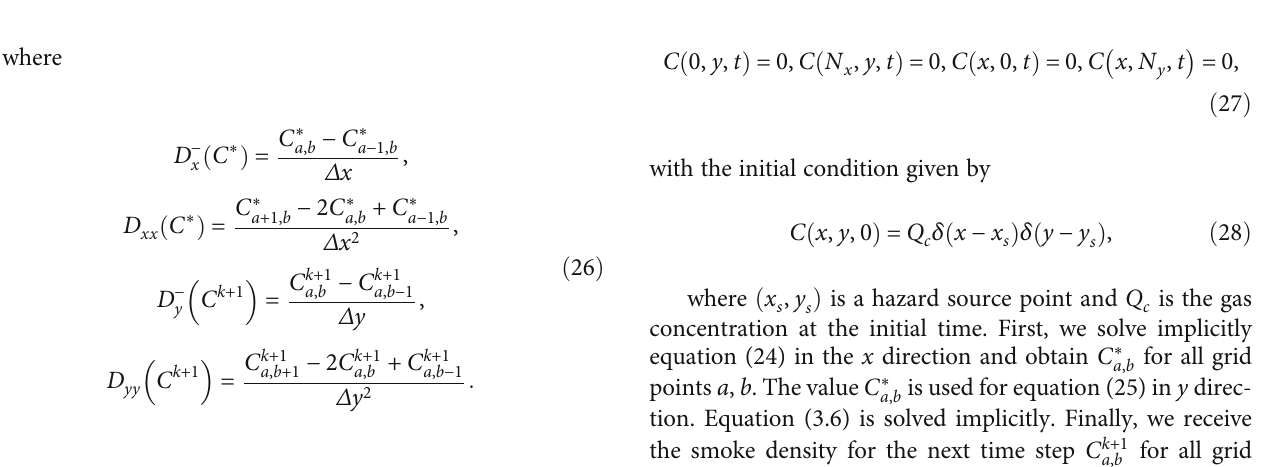
Figure 5: The movements of the pedestrians during smoke spreading, where the source is at Exit 1. The velocity fi eld ð w advection-di ff usion equation (13) is chosen randomly out of the interval